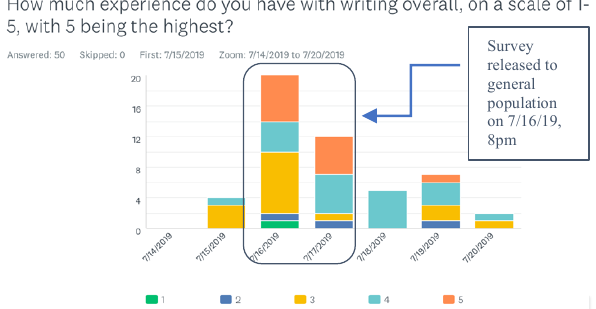
Figure 10 . Time trend, Question 1. More respondents report higher levels of experience with writing on 7/16 – 7/17.